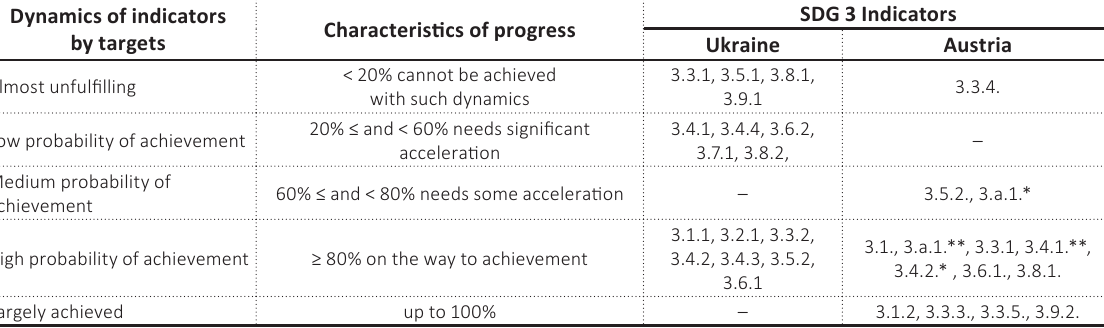
Table 2. The assessment of progress in achieving the targets of SDGs 3 in Ukraine and Austria according to national monitoring